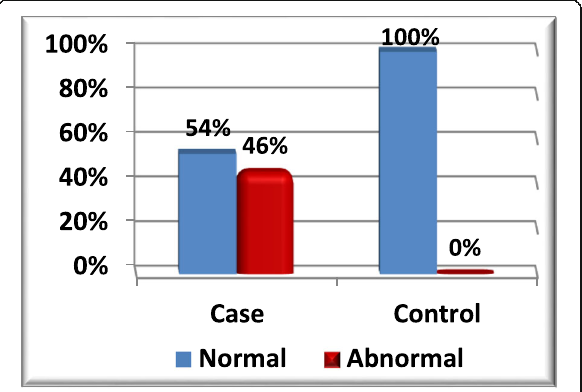
Fig. 1 Prevalence of HOMA-IR in both groups ( p value < 0.001)